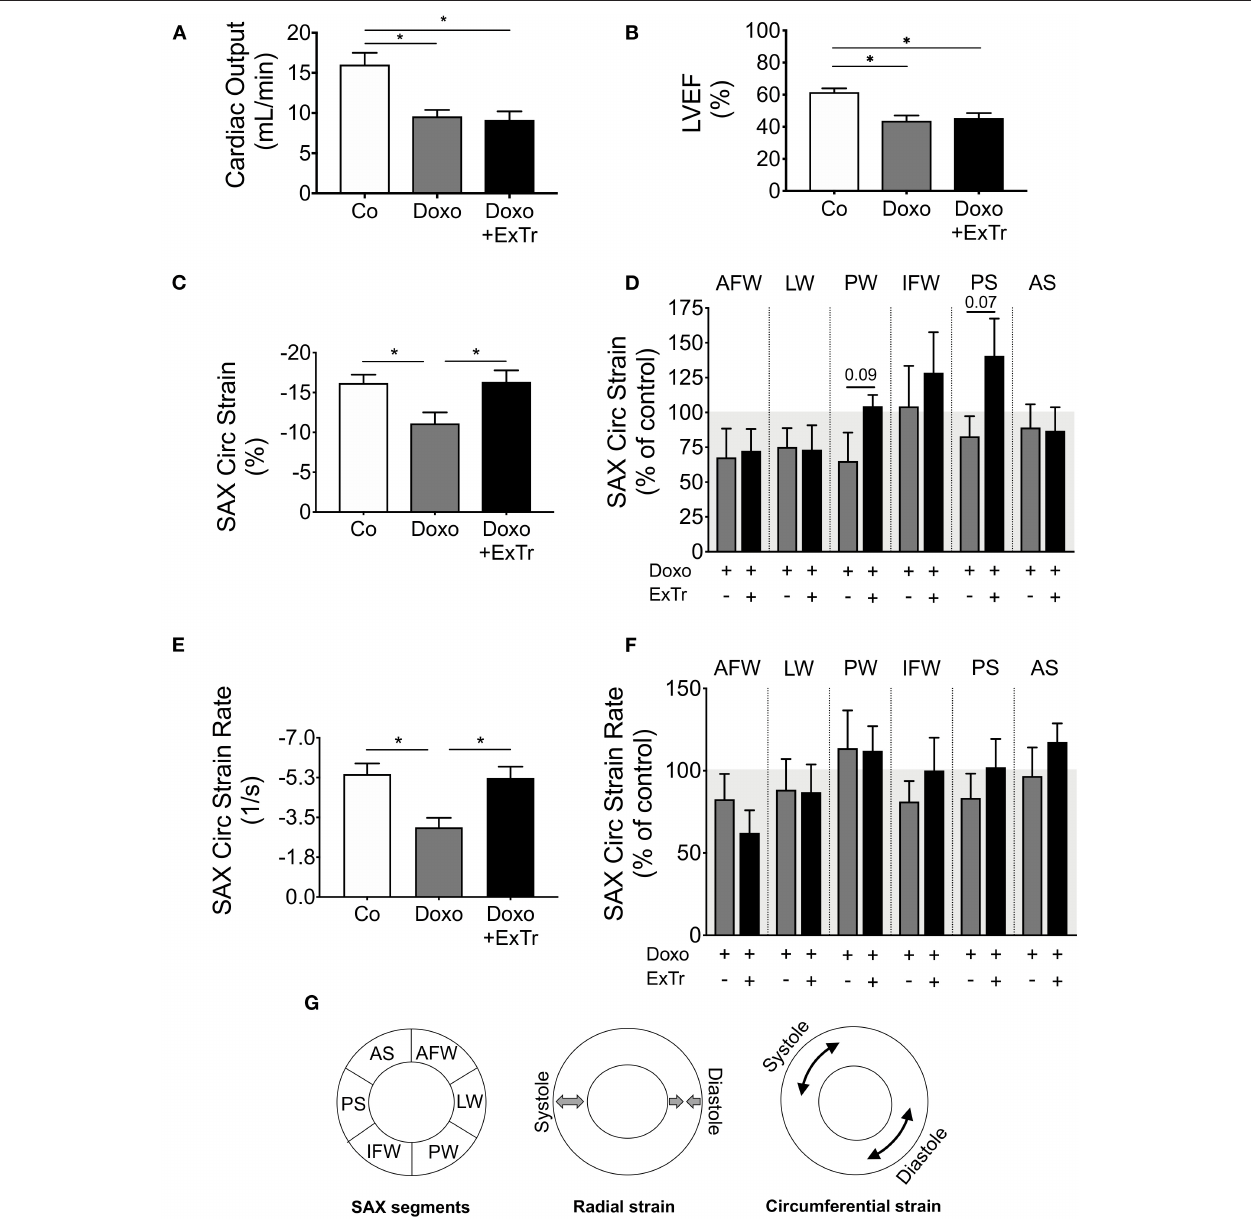
FIGURE 2 | Exercise training alleviates Doxo-induced cardiac dysfunction. Doxo impairs CO (A) and LVEF (B) . However, speckle tracking showed ExTr preserved SAX cardiac contractility, both in the Circ strain (C,D) and strain rate (E,F) , expressed as a final vector from strain (B) and strain rate (D) of different cardiac segments (D,F) . AFW, anterior free wall; AS, anterior septum; CO, cardiac output; Circ, circumferential; IFW, inferior free wall; LW, lateral wall; LVEF, left ventricular ejection fraction; PS, posterior septum; PW, posterior wall; SAX, short axis). Conceptual analysis of speckle tracking on (G) . n = 6–11 per group. Group abbreviations as in Figure 1 . * P ≤